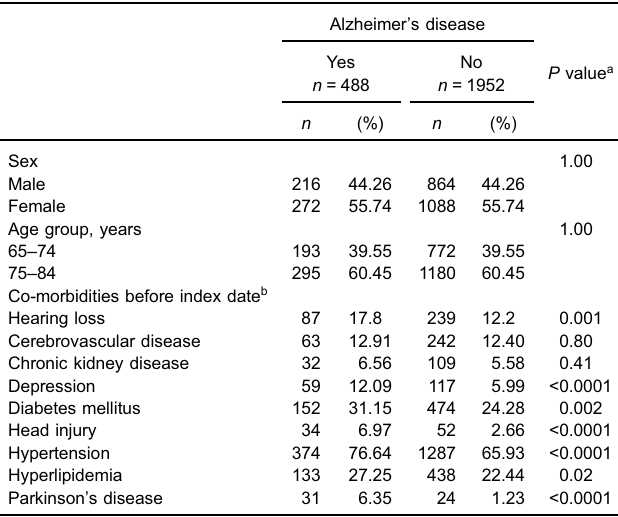
Table 2. Odds ratios of Alzheimer ’ s disease associated with hearing loss and other co-morbidities